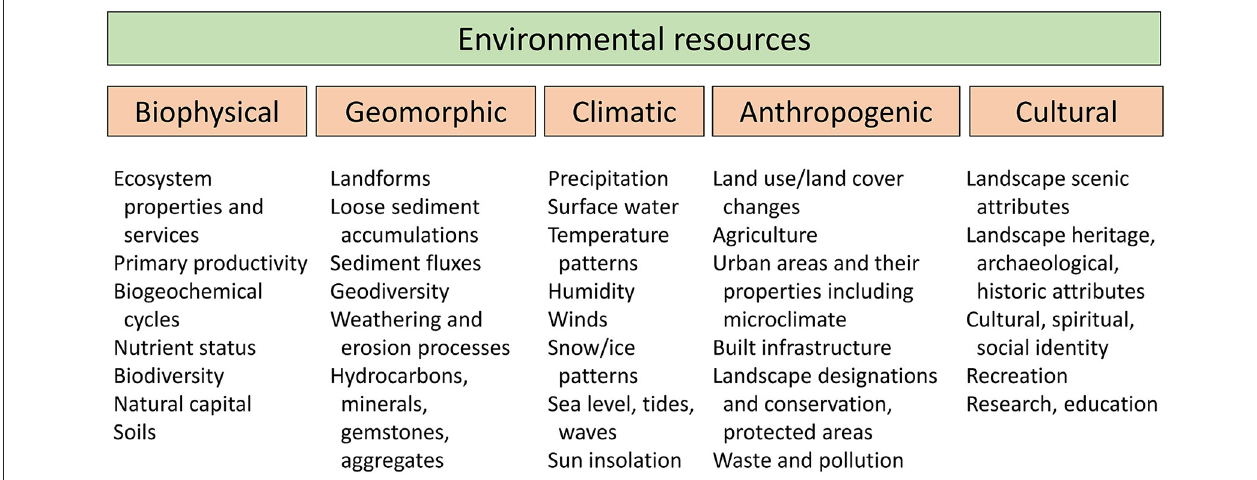
FIGURE 3 | Illustration of different types of environmental resources [informed by Gray (2004), Millennium Ecosystems Assessment (2005)]. Note that ecosystem resources and services are a subset of broader environmental resources and services.